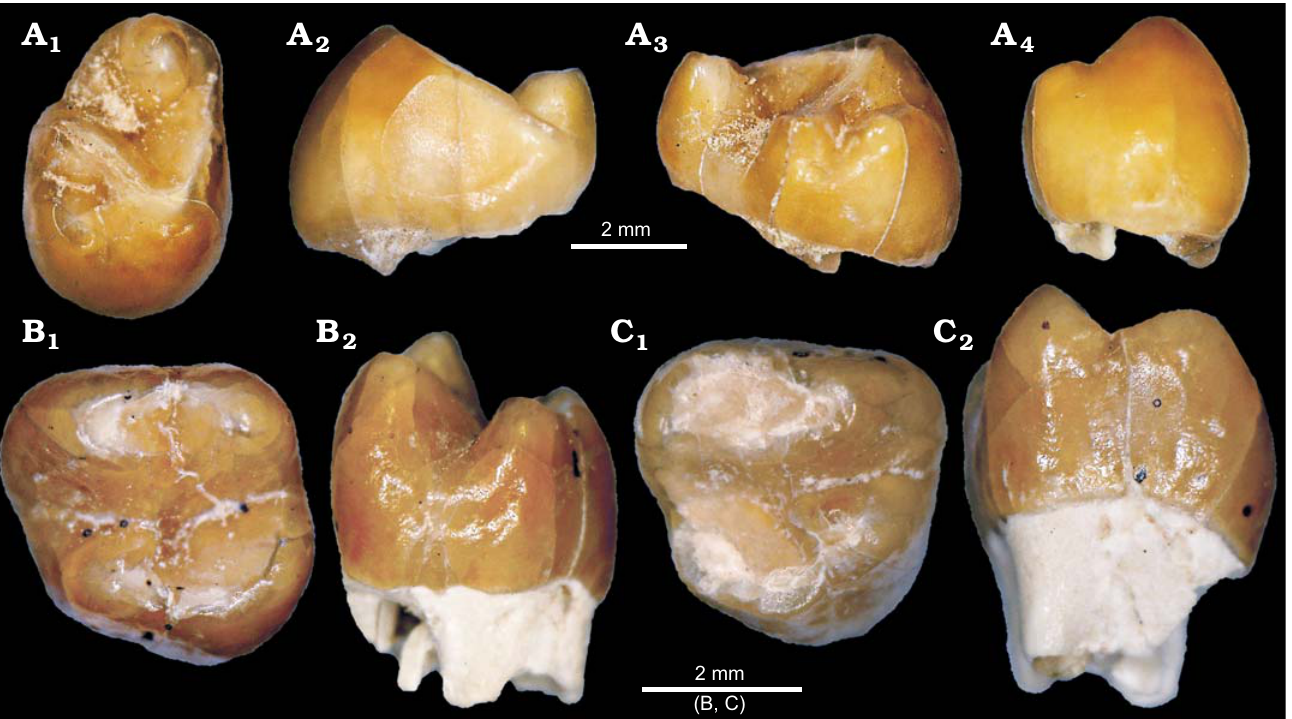
Fig. 3. Mimotonid Gomphos progressus sp. nov. from the Eocene of Wulanhuxiu, Nei Mongol, China. A . Left M3 (IVPP V20824) in occlusal (A 1 ), anterior (A 2 ), posterior (A 3 ), and lingual (A 4 ) views. B . Left m2, holotype (IVPP V20259) in occlusal (B 1 ) and buccal (B 2 ) views. C . Right m3 (IVPP V20259.1) in occlusal (C 1 ) and anterior (C 2 )